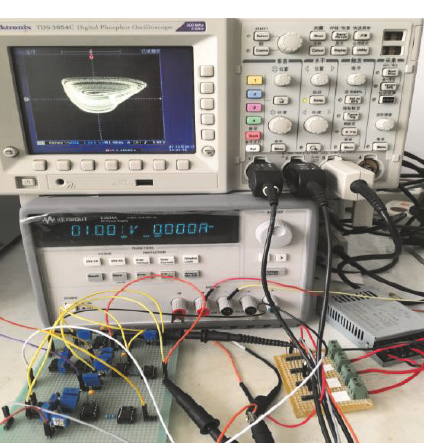
a sinusoidal voltage source V = 𝐴 sin (2𝜋𝑓𝑡) generated by Tek- tronix AFG 3102C Function Generator is linked to the input terminals of the memristor emulator, where the physical frequency is calculated by 𝑓 = 𝐹/𝑅𝐶 . For 𝑘 = 1, the